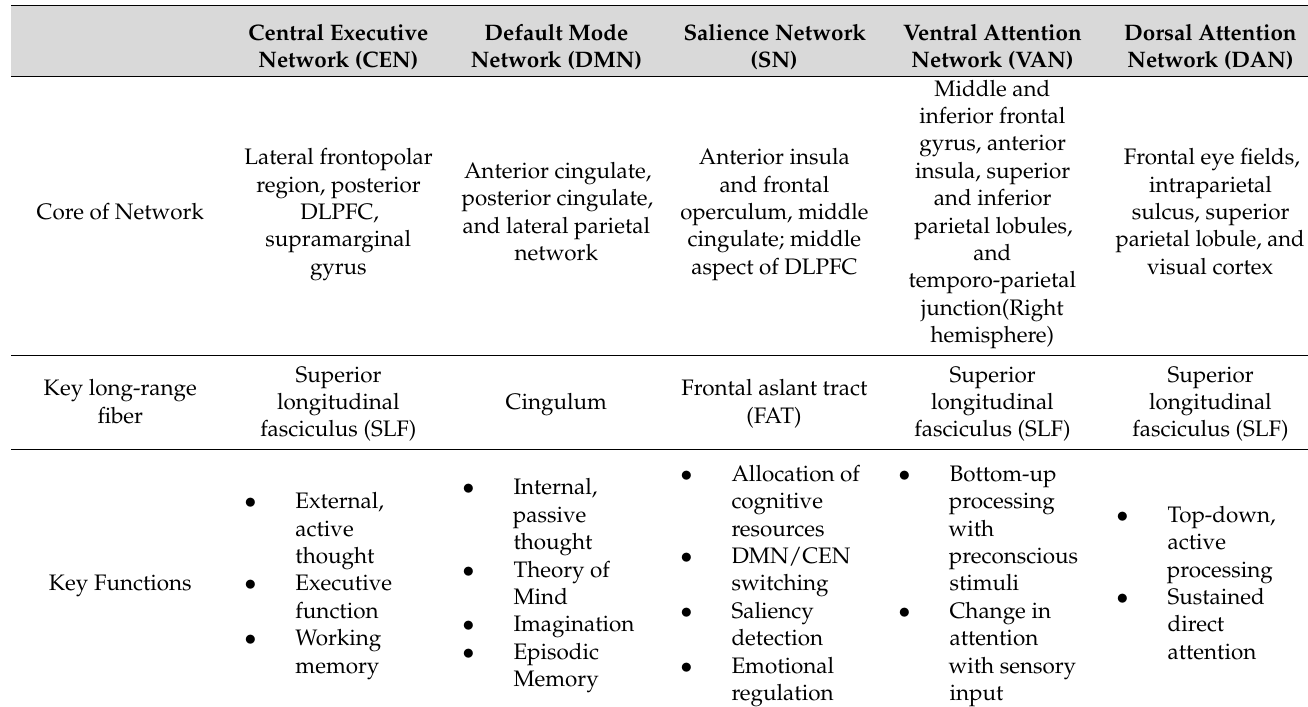
Table 1. Five non-traditional, large-scale brain